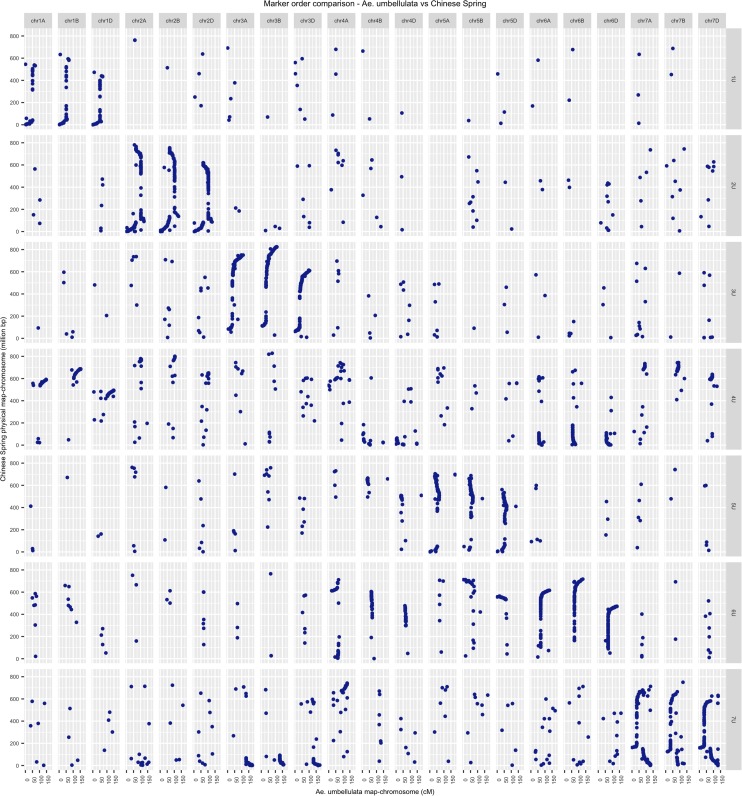
Syntenic relationship between the homeologous chromosomes of Ae. umbellulata and hexaploid wheat. The left y-axis shows Chinese Spring wheat physical map (in million base pair), and the bottom x-axis identifies genetic distance (centimorgan) of Ae. umbellulata chromosomes. The upper x-axis represents chromosomes of Chinese Spring wheat, whereas the left y-axis represents chromosomes of Ae. umbellulata.